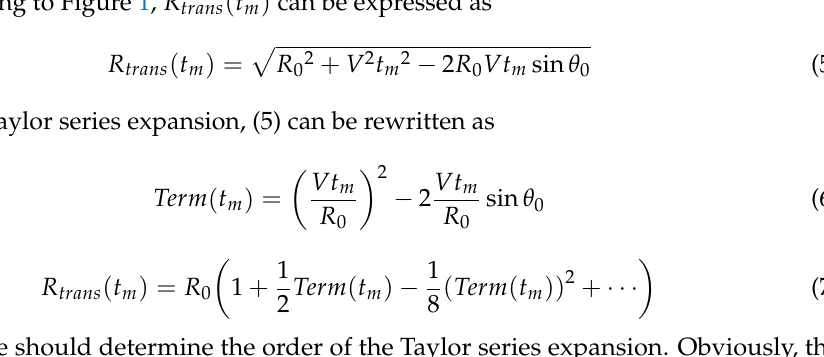
Figure 1. The motion of the target relative to the radar, where R 0 is the initial distance between radar and target, R trans ( t m ) is the translational motion of the target, V is the speed of the target and θ 0 is the initial oblique angle.